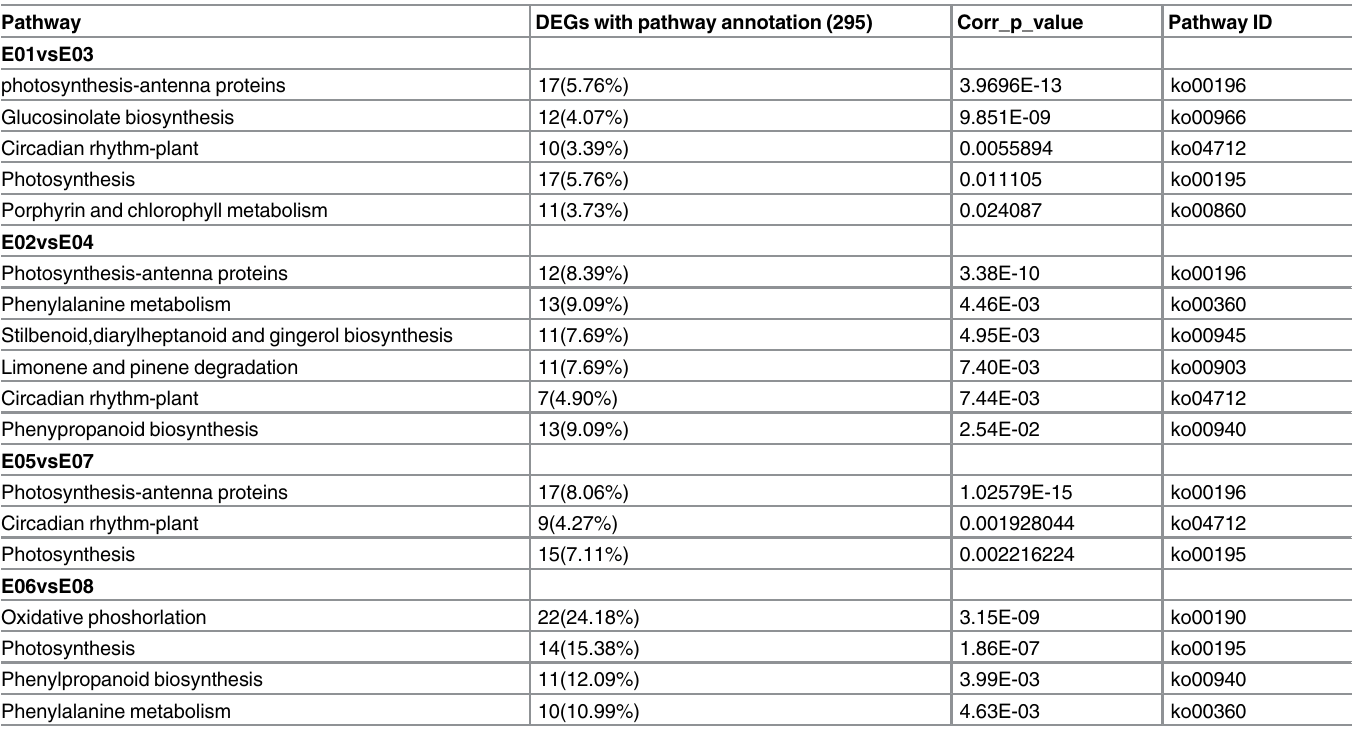
Table 2. KEGG Pathway Enrichment Analysis of